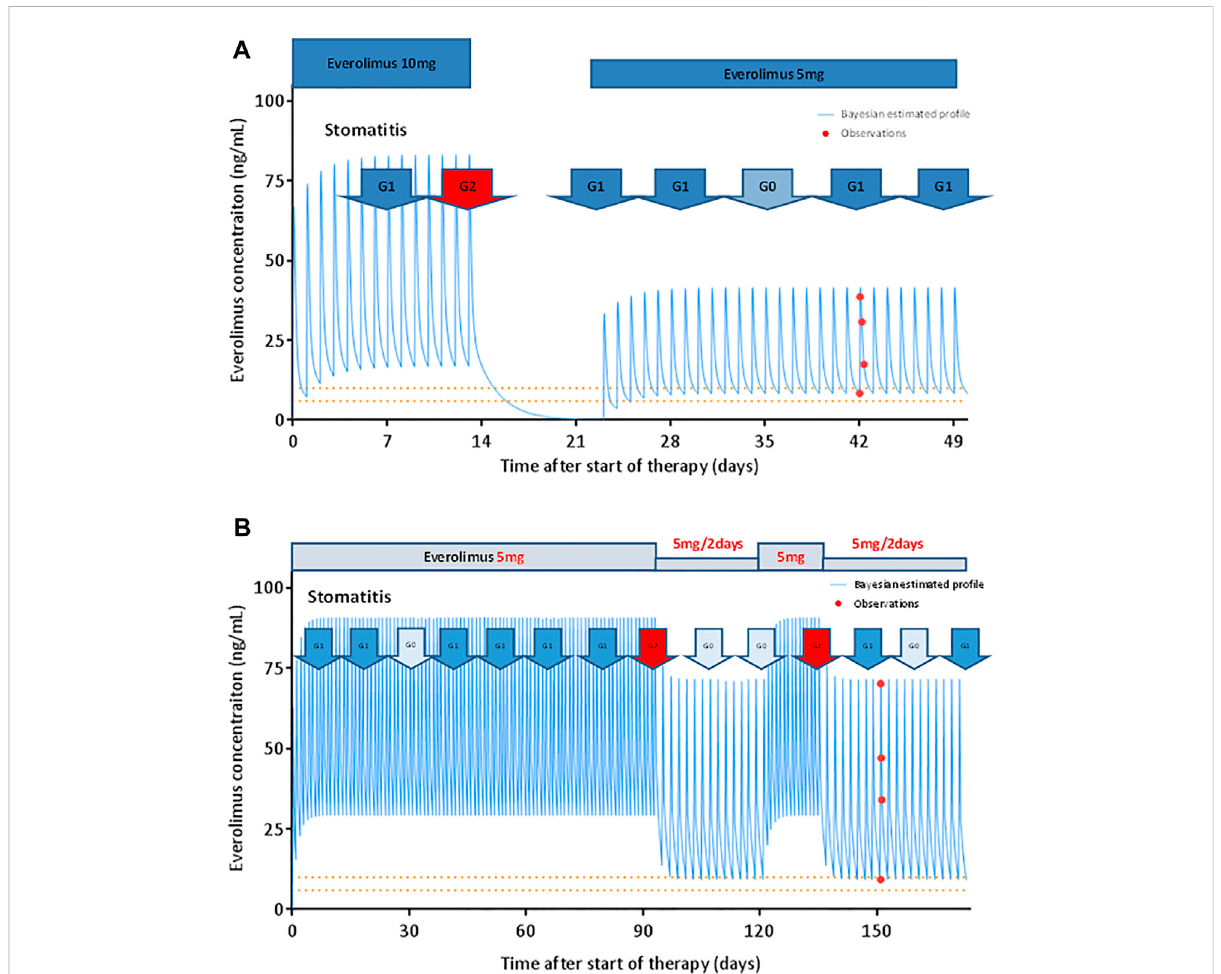
FIGURE 3 Model-based prediction of everolimus PK pro fi le in representative patients. (A) Everolimus starting dose was 10 mg once daily. The patient exhibited grade 2 stomatitis 14 days after treatment initiation. Subsequent doses were suspended for 10 days. After everolimus treatment was resumed at 5 mg once daily, the patient did not show any dose-limiting toxicity. The patient continued the therapy for 8.5 months. The solid line represents the Bayesian estimated everolimus concentration pro fi le. The closed circles represent observed blood concentrations. The dashed lines indicate the target trough concentration range suggested in patients with renal transplant (calcineurin-inhibitor-free regimen). (B) Everolimus startingdosewas5 mgoncedaily.Thepatient exhibited grade2stomatitis 90 daysafter treatment initiation.Thedoseofeverolimuswasreducedto 5 mgeveryalternateday.Thestomatitissubsequently improved,and28dayslater,everolimuswasresumedat5 mgoncedaily.Twoweekslater,the stomatitis worsened to grade 2. The everolimus dose was reduced to 5 mg every alternate day. The patient then progressed with stomatitis grade 0 – 1 and continued the therapy for 13.8